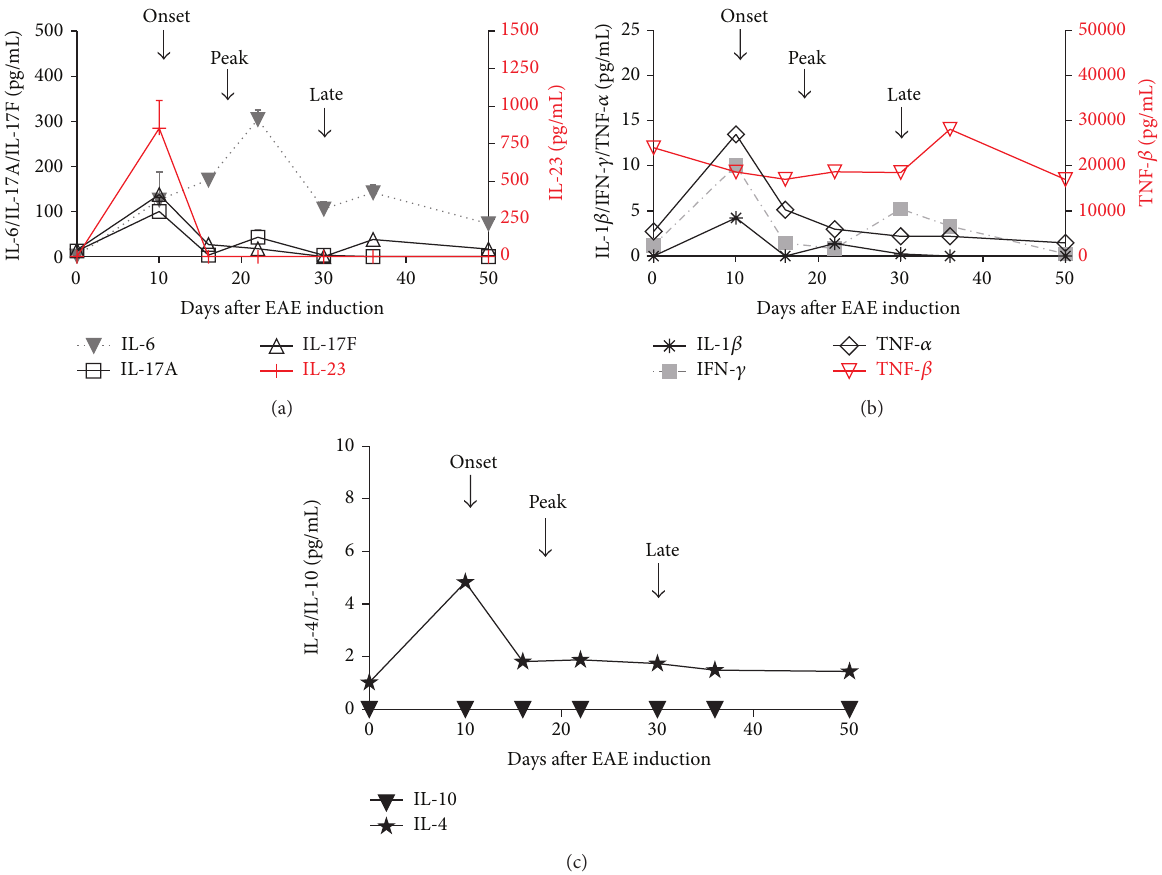
Figure 6: Cytokines levels in plasma samples of EAE mice at the different times of EAE progression. Blood samples were taken at different times of EAE progression, before EAE induction (day 0), at the onset (day +10), before the peak (day +16), after the peak (day +22), at the time of EAE stabilization (day +30), after EAE stabilization (day +36), and at the end of experiment (day +50). Plasma samples were isolated by centrifugation and stored at − 80 ∘ C until being used. Cytokines levels were detected using Milliplex mouse Th17 magnetic bead panel on Luminex 200 instrument (Merck, Millipore) and the kinetics were plotted of (a) Th1, (b) Th17 cytokines profiles and (c) IL-4 and IL-10 of EAE mice ( 𝑛 = 7 , each experiment). The samples of each experiment were pooled and analyzed independently in